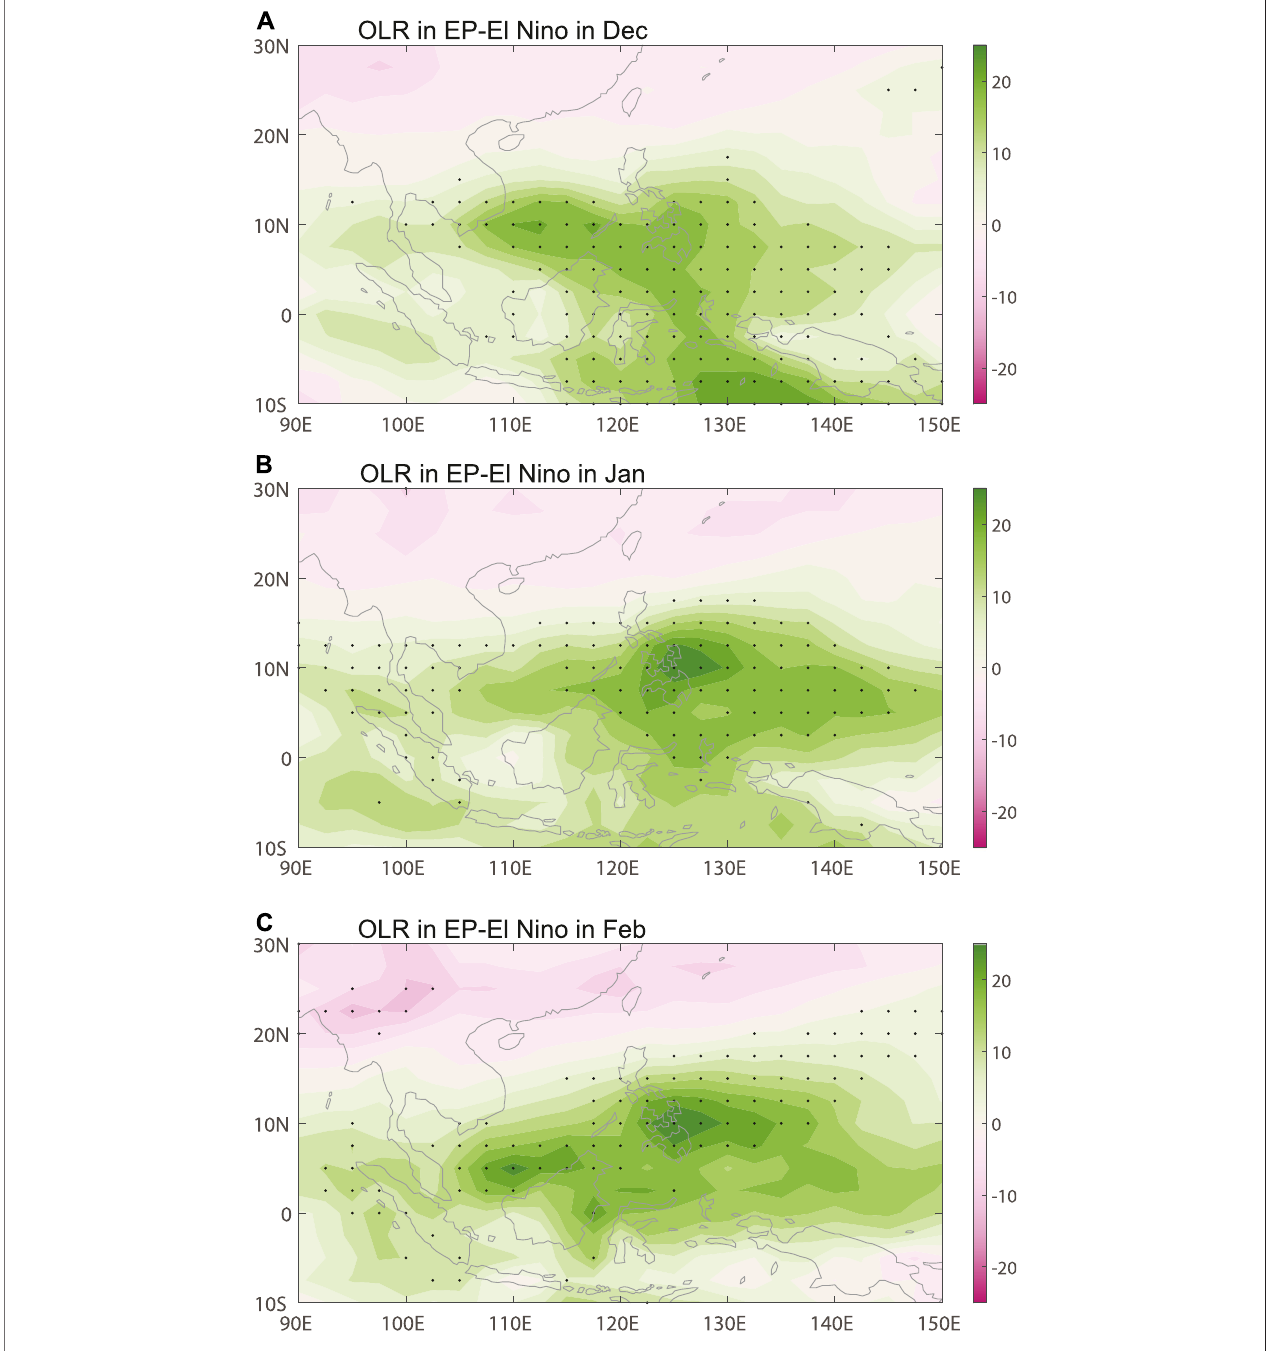
FIGURE 6 | OLR anomalies (units: W m − 2 ) during El Niño mature phases in (A) December, (B) January, and (C) February. Dotted areas indicate the 0.05 signi fi cance level.